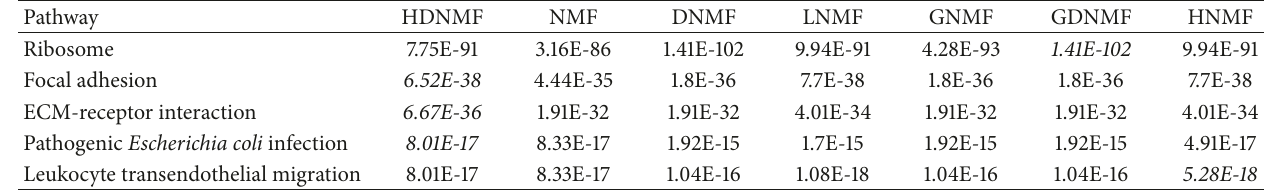
Table 11: The FDR of different methods (INTA 1).